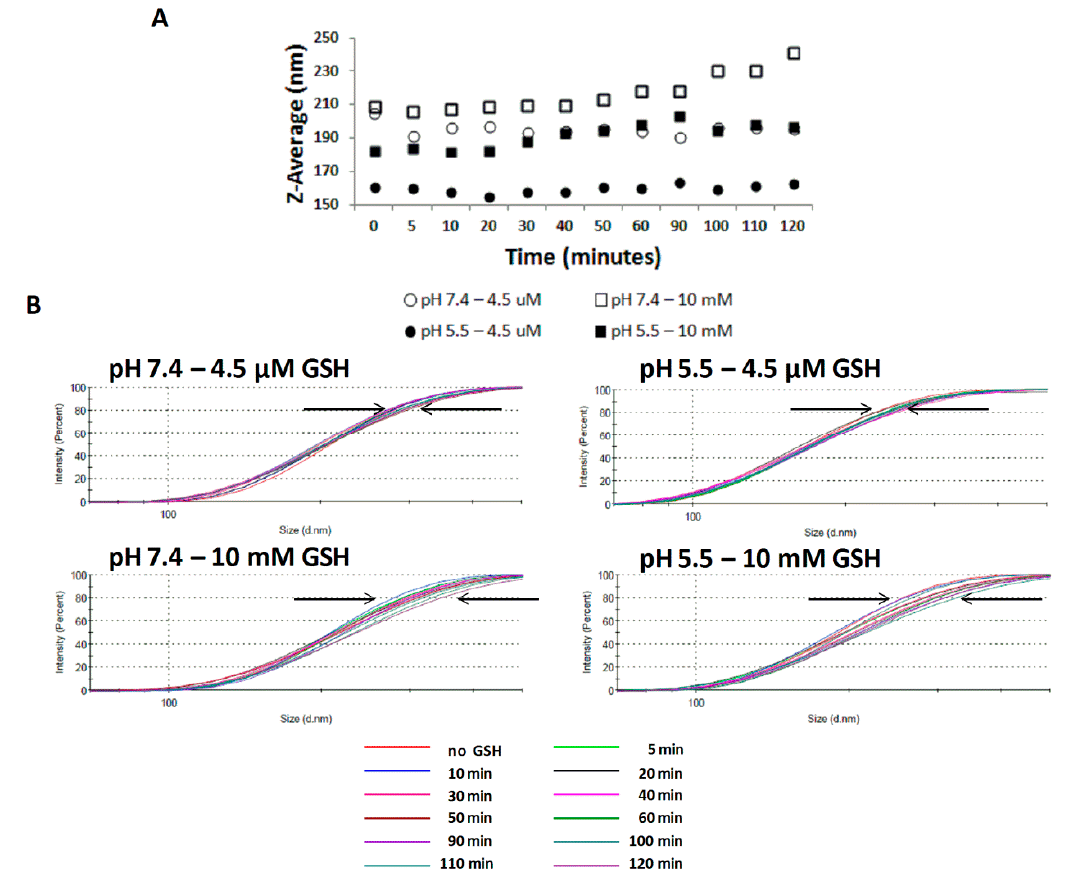
Figure 5. Particle size of ICD@SS@SPIONs upon treatment with GSH 4.5 µM (extracellular environment) and 10 mM (intracellular environment) at two different pH (7.4 and 5.5). ( A ) Z-average distribution over time. ( B ) Cumulative undersize distribution over time.